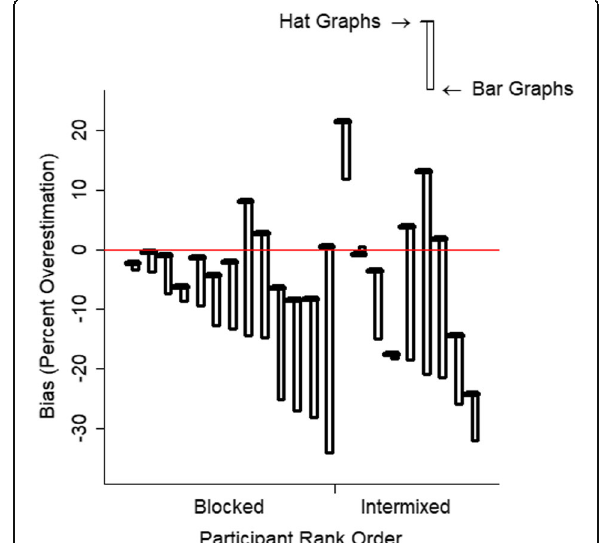
Fig. 15 Bias in estimated effect size was calculated as a percent overestimation score. Positive values indicate a bias toward overestimation, and negative values indicate a bias toward underestimation. A score of 0 indicates no bias. Data are plotted for each participant, and participant is ordered based on design (blocked or intermixed) and then from largest to smallest bias with the bar graph. The brim corresponds to the hat graphs, and the edge of the crown corresponds to the bar